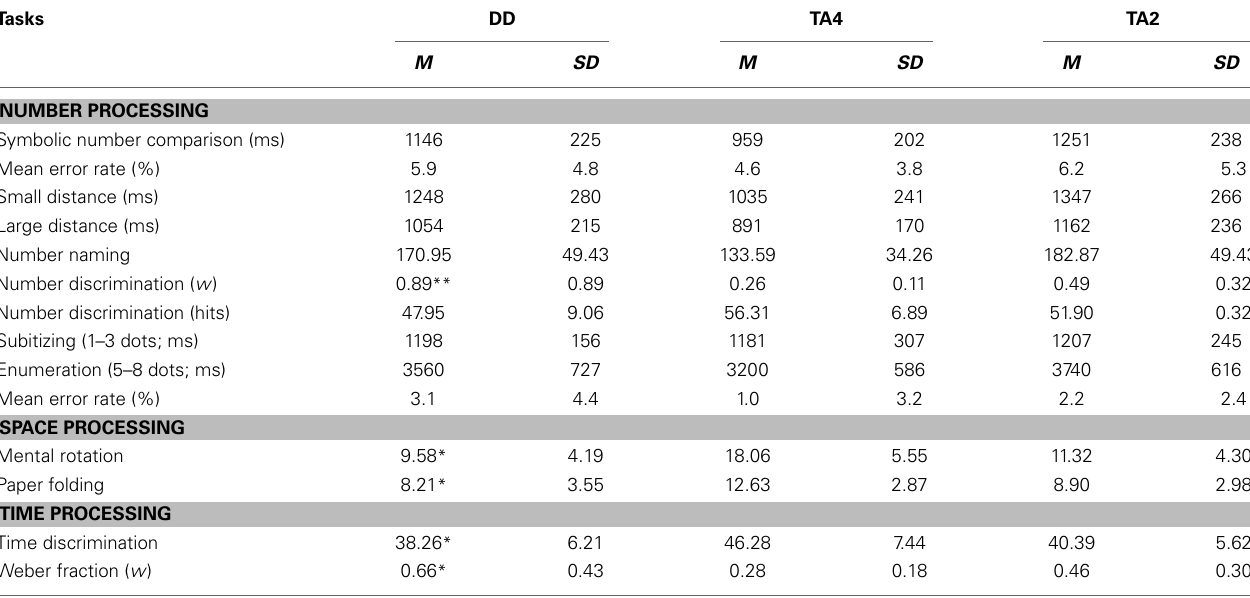
Table 3 | Overview of magnitude